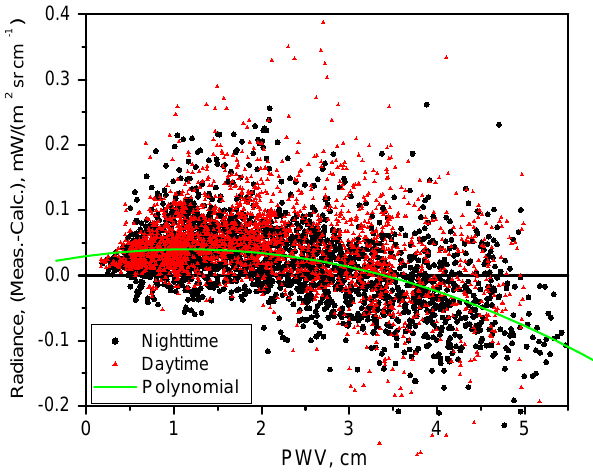
Fig. 5. Radiances averaged over 2 spectral intervals taken together: between 2142.7–2144.1cm − 1 and 2167.2-2168.7cm − 1 used for verification of kCARTA calculations. Differences between mea- sured and calculated radiances for daytime and nighttime are plotted as a function of PWV.